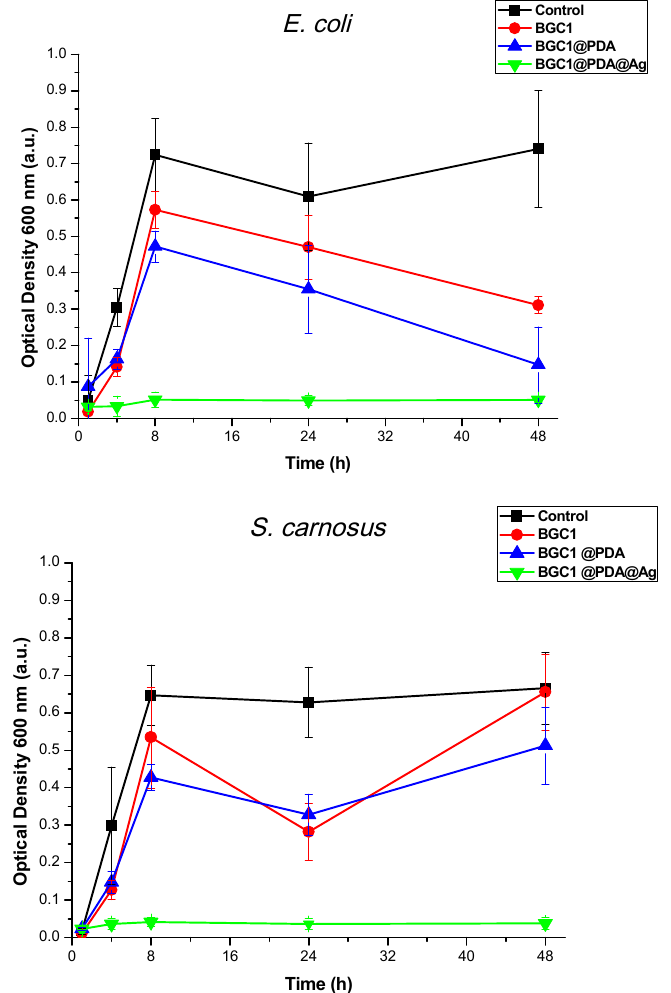
Figure 6. Turbidity measurements on suspensions of both tested Staphylococcus carnosus and Escherichia coli strains in lysogeny broth (LB) medium on different samples, showing their different antibacterial effects.